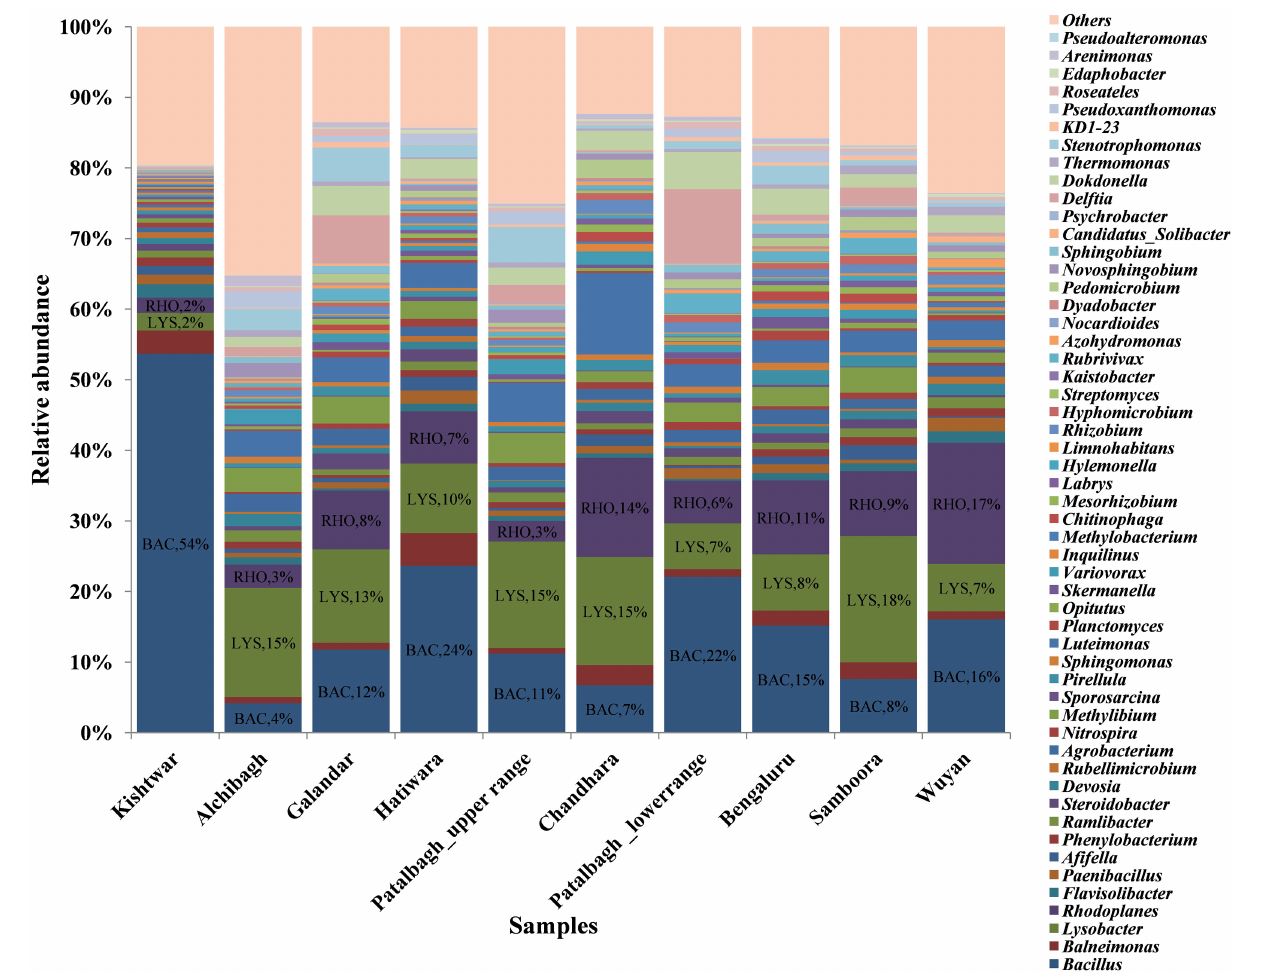
FIGURE 3 | Comparison of bacterial genera in saffron rhizosphere from different geographical locations. The OTU cataloged up to genus level were normalized to 10,000. BAC, Bacillus; LYS, Lysobacter ; RHO, Rhodoplane; JAN, Janthiobacterium were dominant genera in these samples. In this figure, Kishtwar sample is distinct from the Kashmir samples. The microbial communities of Kashmir and Bengaluru samples are similar as compared to Kishtwar